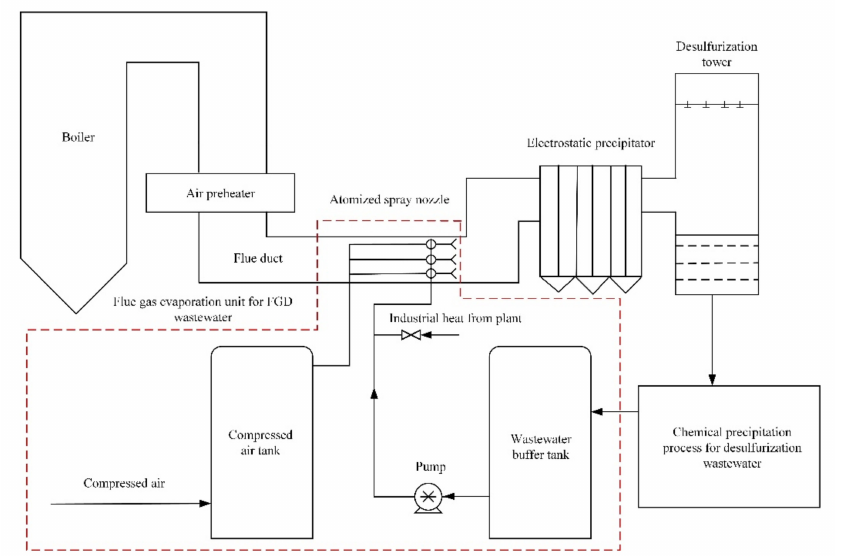
Figure 1. Typical treatment process of spraying FGD wastewater in flue duct for